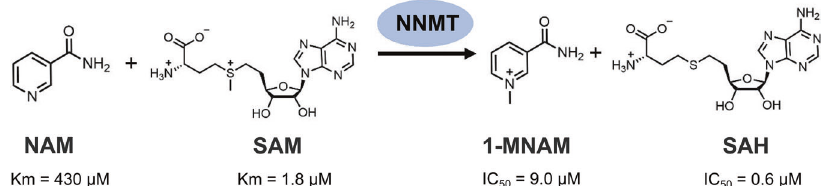
Fig. 1 NAM N-methylation reaction catalyzed by NNMT. NNMT catalyzes the methylation of NAM to 1-MNAM by using SAM as a co- substrate. Human liver NNMT has apparent Km values for NAM and SAM, of 430 and 1.8 μ M, respectively. 1-MNAM and SAH inhibit the methyltransferase activity of NNMT with IC 50 values of 9.0 and 0.6 μ M,